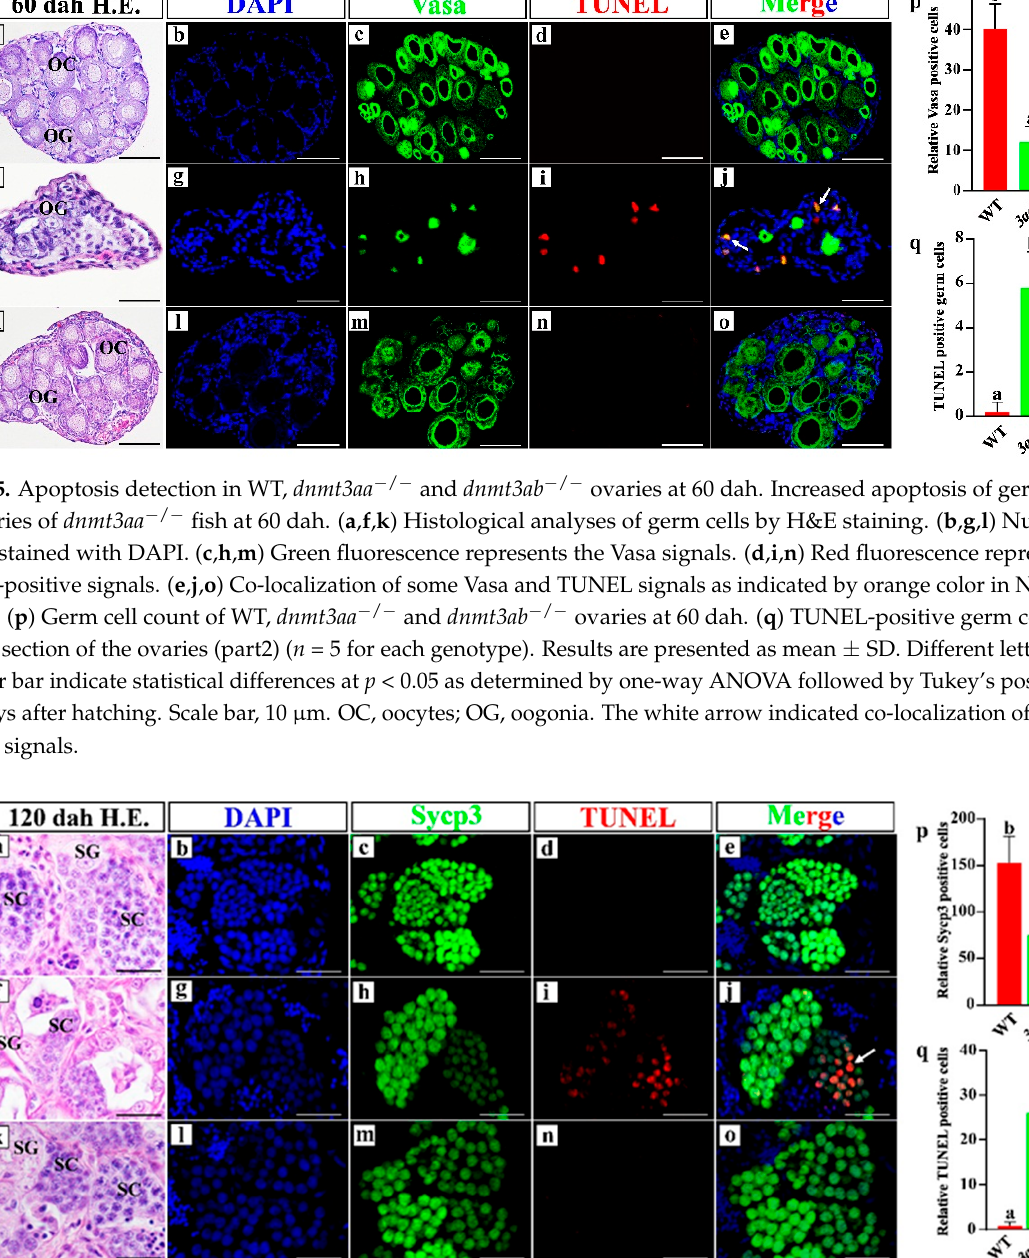
Figure 6. Apoptosis detection in WT, dnmt3aa − / − and dnmt3ab − / − testes at 120 dah. Increased apoptosis of spermatocytes in the testes of dnmt3aa − / − fish at 120 dah. ( a , f , k ) Histological analyses of germ cells by H&E staining. ( b , g , l ) Nuclei were counterstained with DAPI. ( c , h , m ) Green fluorescence represents the Sycp3 signals. ( d , i , n ) Red fluorescence represents the TUNEL-positive signals. ( e , j , o ) Co-localization of some Sycp3 and TUNEL signals as indicated by orange color in Nile tilapia testes. ( p ) Sycp3-positive cell count of WT, dnmt3aa − / − and dnmt3ab − / − testes at 120 dah. ( q ) TUNEL-positive cells in the entire median section of the testes ( n = 5 for each genotype). Results are presented as mean ± SD. Different letters above the error bar indicate statistical differences at p < 0.05 as determined by one-way ANOVA followed by Tukey’s post hoc test. dah, days after hatching. Scale bar, 10 µ m. SC, spermatocytes; SG, spermatogonia. The white arrow indicated co-localization of Sycp3 and TUNEL